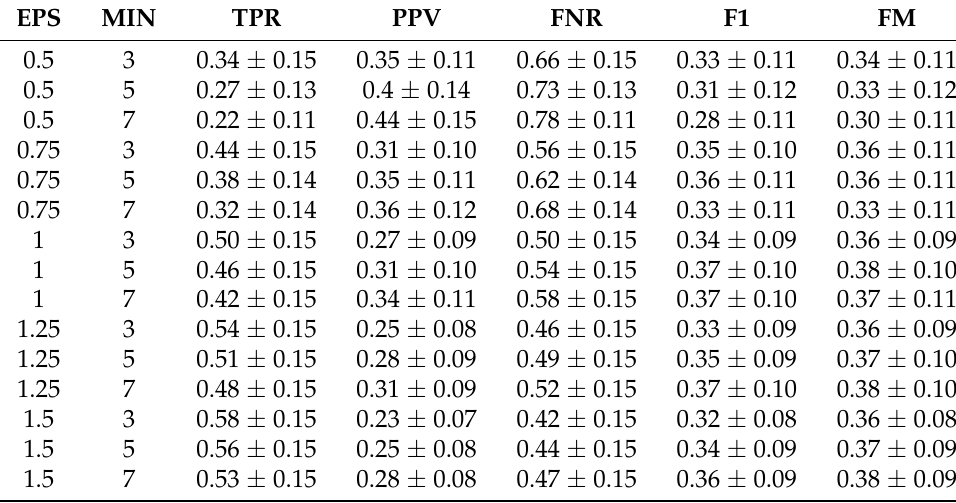
Table 4. Evaluation results of SLAM-OR (YOLO v4) algorithm depending of DBSCAN parame- ters